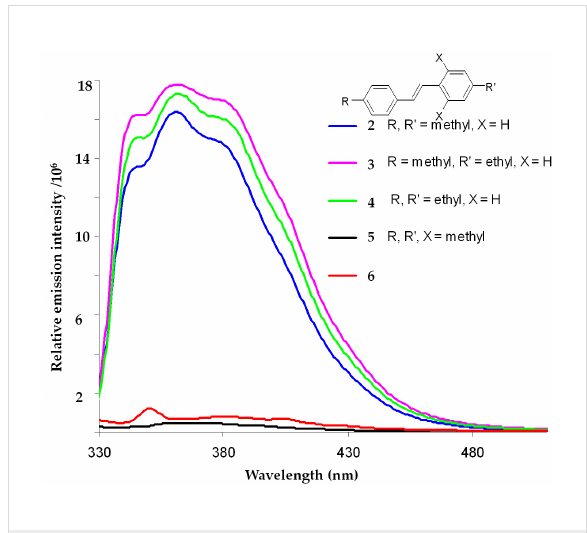
Figure 2: Room temperature fluorescence spectra at λ exc = 318 nm for 10 µM mesitylene solutions of 4,4′-dimethylstilbene ( 2 ); 4-ethyl-4′- methylstilbene ( 3 ); 4,4′-diethylstilbene ( 4 ); 2,4,4′,6-tetramethylstilbene ( 5 ) and assembly 6 (λ exc = 300